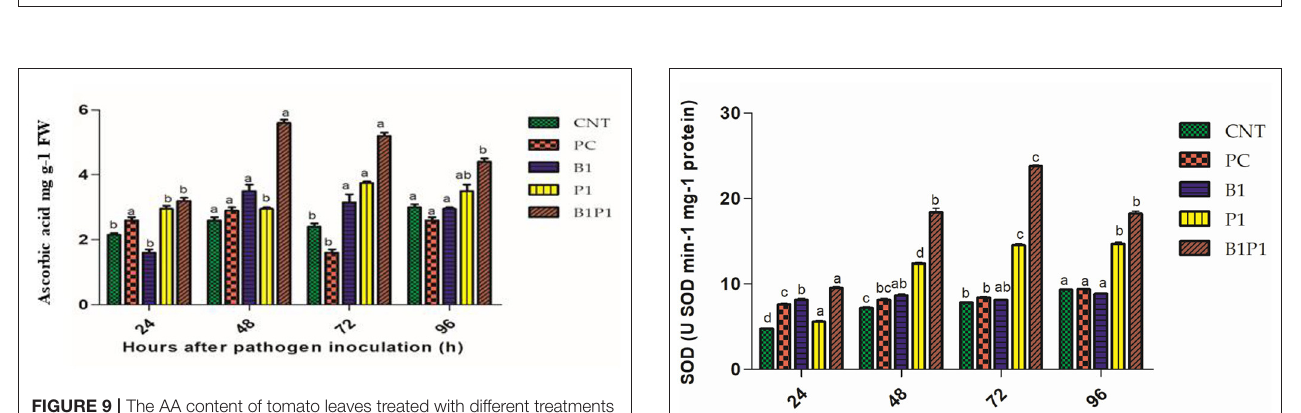
FIGURE 9 | The AA content of tomato leaves treated with different treatments of 24–96h of pathogen inoculation. Data are shown as a mean ± SE ( n = 3). Tukey’s B post-hoc test at 5% confidence level ( p < 0.05) was used to test the significance of the data. These alphabets denoted the different significant level. FIGURE 10 | The SOD activity of tomato leaves treated with different treatments of 24–96h of pathogen inoculation. Data are shown as mean ± SE ( n = 3). Tukey’s B post-hoc test at 5% confidence level ( p < 0.05) was used to test the significance of the data. These alphabets denoted the